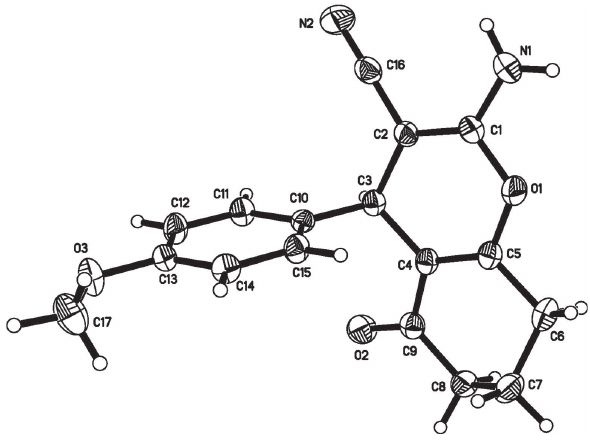
Table 2: Fractional atomic coordinates and isotropic or equivalent isotropic displacement parameters (Å 2